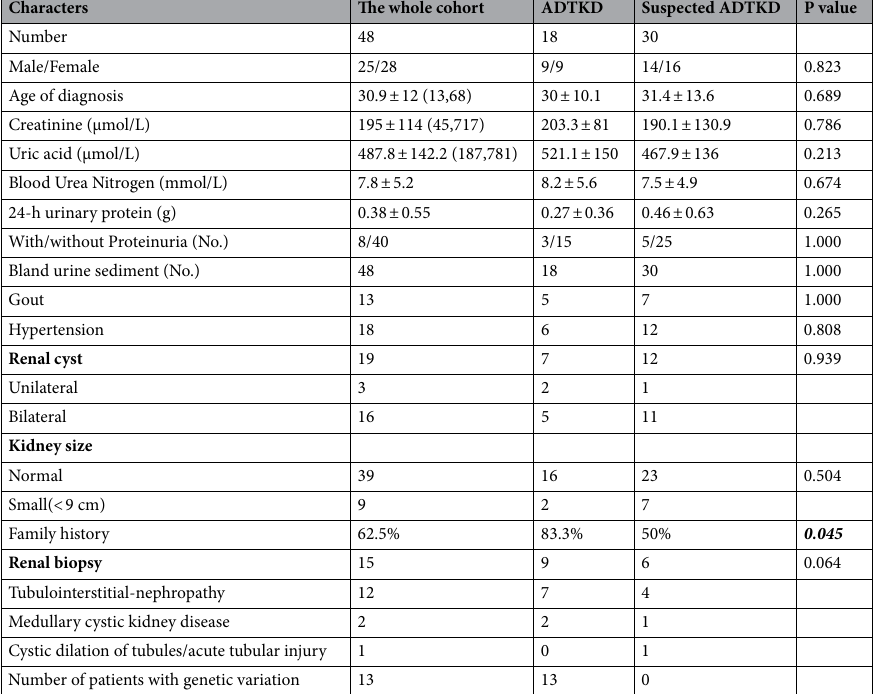
Table 1. Clinical features of the cohort. Family history Family history positive means there were other family members with renal disease or hyperuricemia, ADTKD autosomal dominant tubulointerstitial kidney